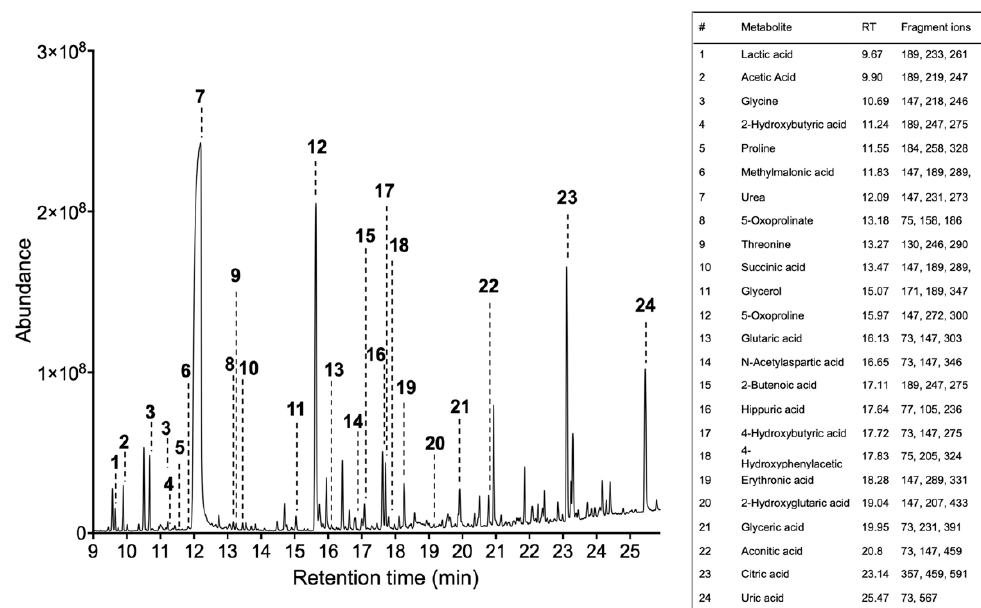
Figure 2. GC-MS total ion current chromatogram (TIC) of metabolites extracted from human urine